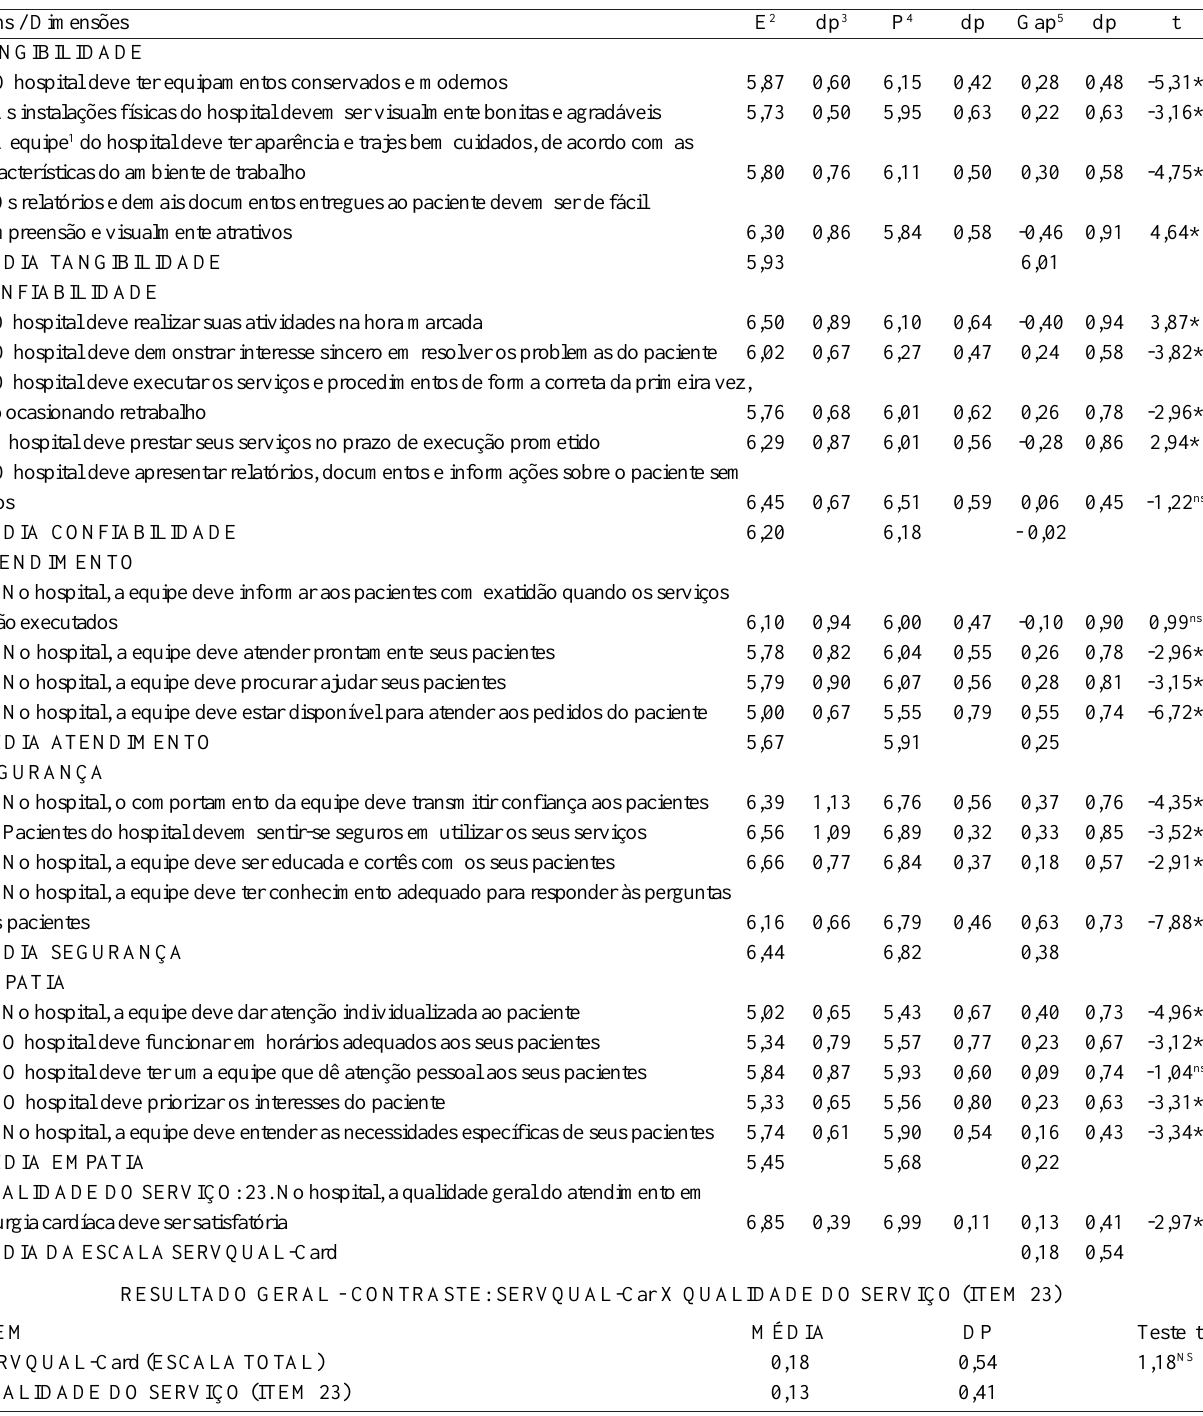
Tabela 2. Desempenho dos itens e dimensões, por meio de médias e desvios-padrão, dos escores Expectativa (E), Percepção (P), Gap = [P -